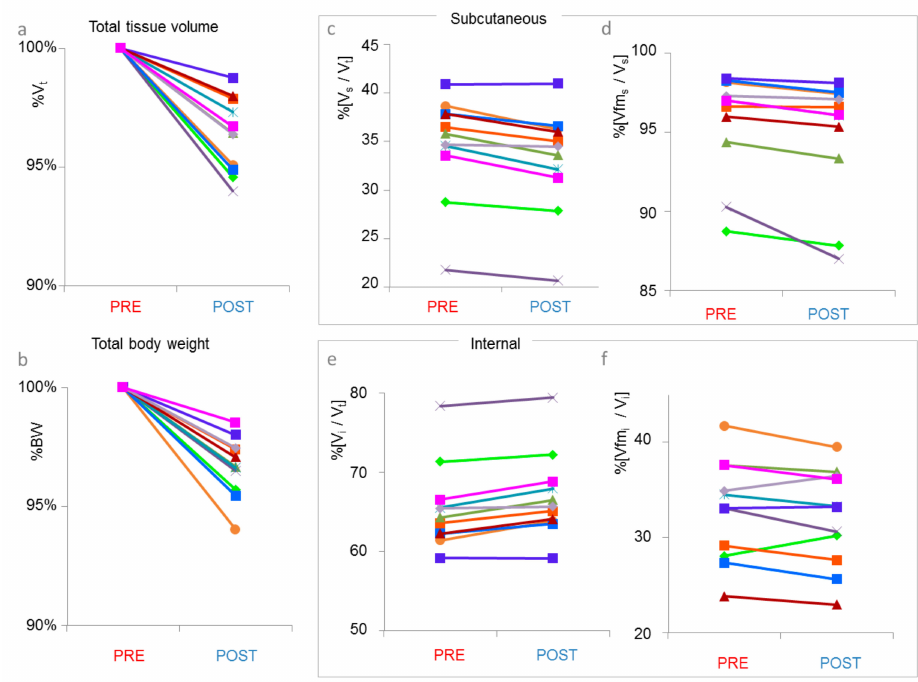
Figure 2. Line plots showing changes of individual subjects’ MRI data. Each plot on the left contains PRE values before diet and on the right contains POST values after six weeks. ( a ) Total tissue volume V t normalized to the total tissue volume PRE. ( b ) Total body weight normalized to the total body weight PRE ( c ) Subcutaneous volume V s normalized to V t . ( d ) Subcutaneous fat mass volume Vfm s normalized to V s. ( e ) Internal volume V i normalized to V t . ( f ) Internal fat mass volume Vfm i normalized to V i